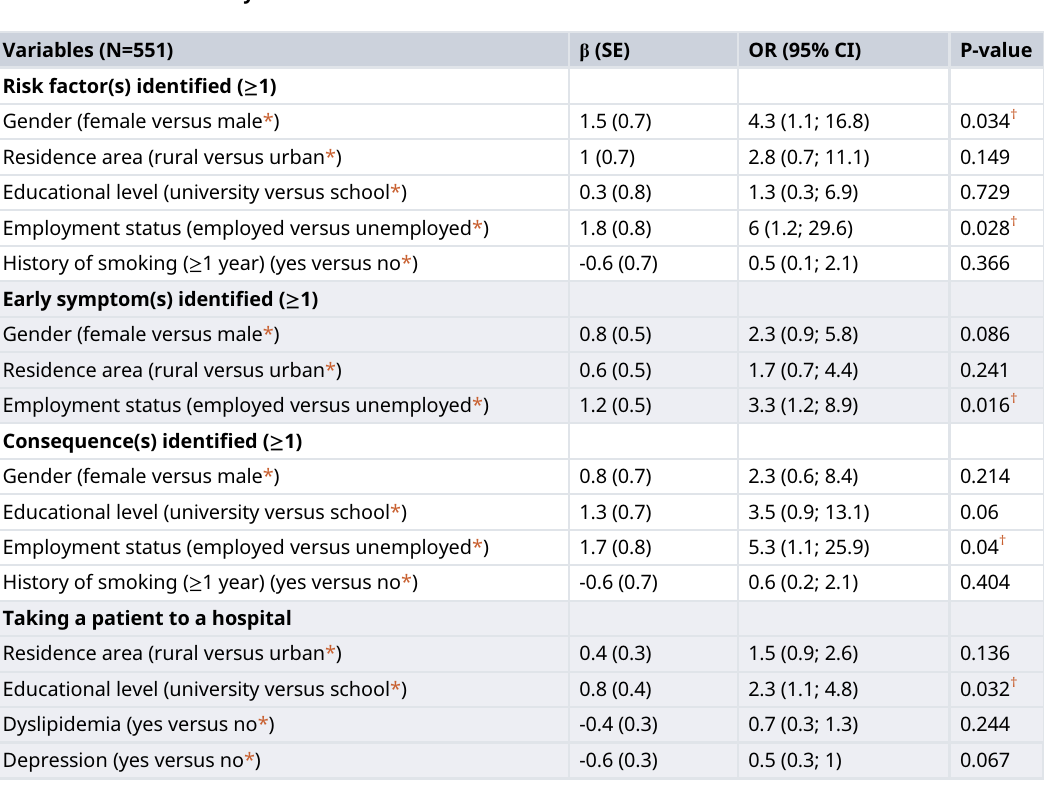
Table 5. Multivariate